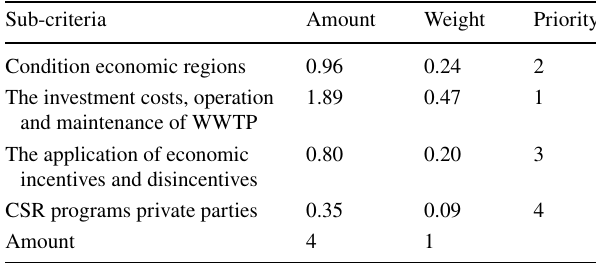
*The amount is indicated the total of the normalization matrix i to j for each sub-criteria in